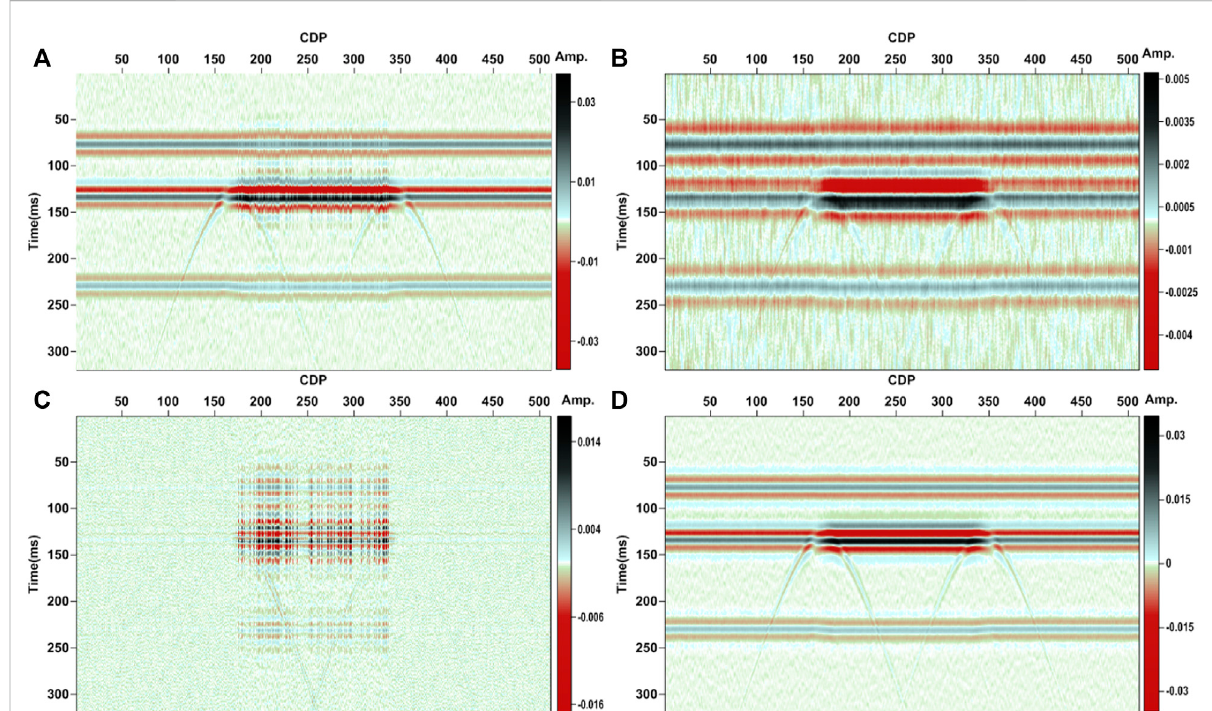
FIGURE 5 Modelanalysis. (A) IMF1obtained byVMD. (B) IMF1obtained byMVMD. (C) IMF2obtained byVMD. (D) IMF2obtained byMVMD. Itisofnotethat for MVMD, the number of data channels is 6. The number of the prede fi ned multivariate modulated oscillations for VMD and MVMD is 2. The moderate bandwidth constraint for VMD and MVMD is